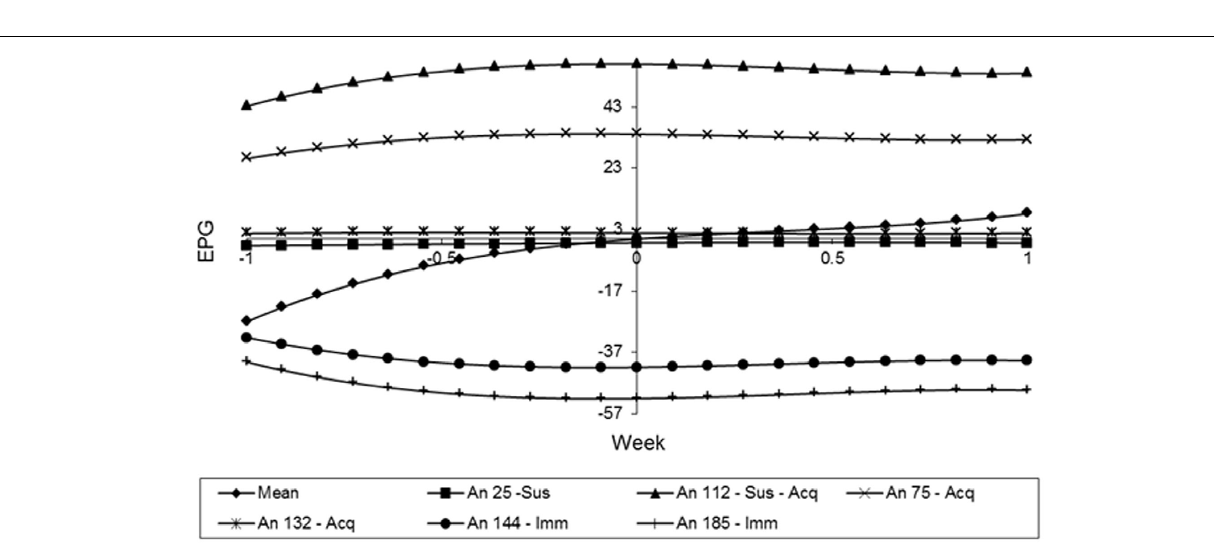
FIGURE 9 | Estimates of the resistance using the random regression curves over time for different